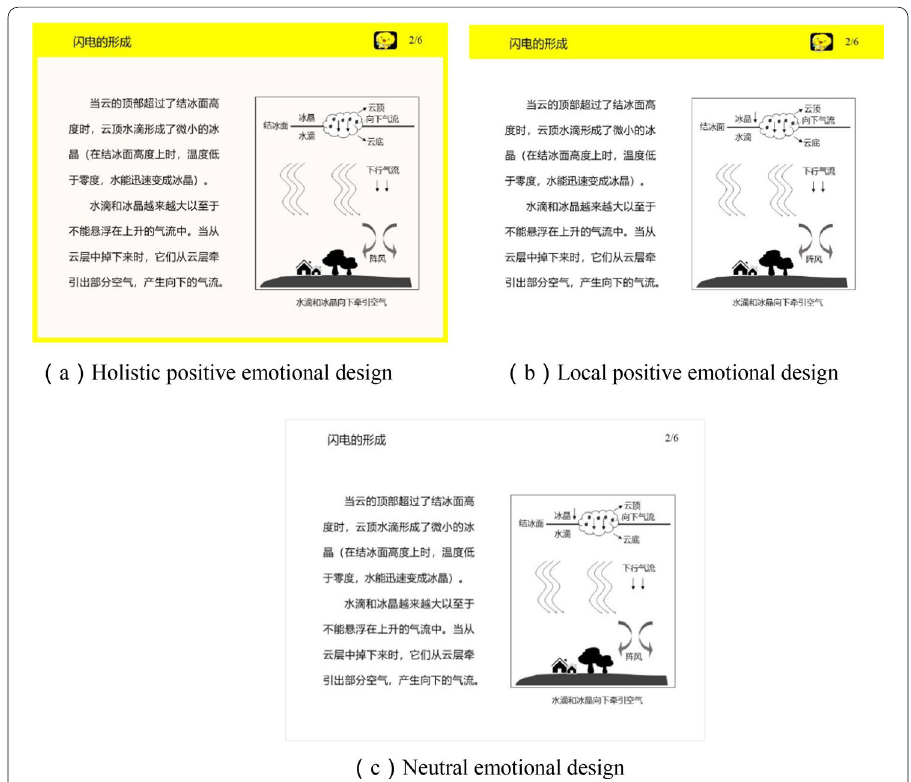
Fig. 1 Screenshot of the learning material in the positive versions (up; HPED and LPED) and the neutral version (down;